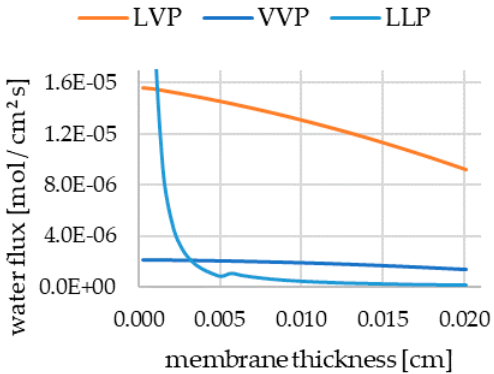
Figure 2. Estimated Water flux through the membrane at 70 °C (Equations (24)–(32), adjusted with data from Adachi et al. [24]); VVP: cathode 96%, anode 38% RH; LVP: cathode liquid volume fraction 100% (flooded), anode 38% RH; LLP: cathode and anode flooded, ∆𝑝 1 [bar] note: only a few data points were available to develop each function, which leads to some numerical inaccuracies.